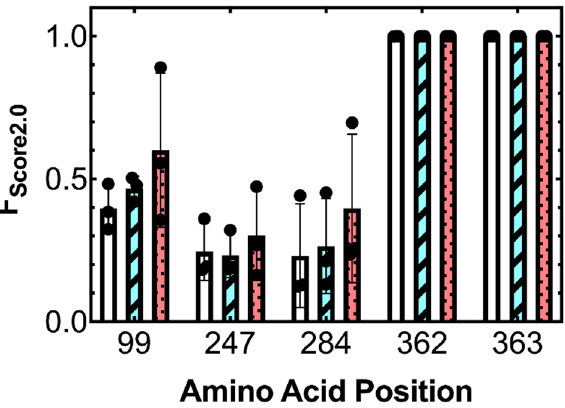
Figure 2. F Score2.0 values reflecting changes in dynamics of backbone dihedral angles at candidate labeling positions. Changes in dynamics of candidate labeling positions relative to dynamics in the TogB apo state are shown for TogB · unsatdigalUA (white bars), TogB · digalUA (cyan striped bars), and TogB · trigalUA (red dotted bars). Each bar reflects the results of 3 replicates ± s.d. with results from individual molecular dynamics simulations superimposed on the plot (black